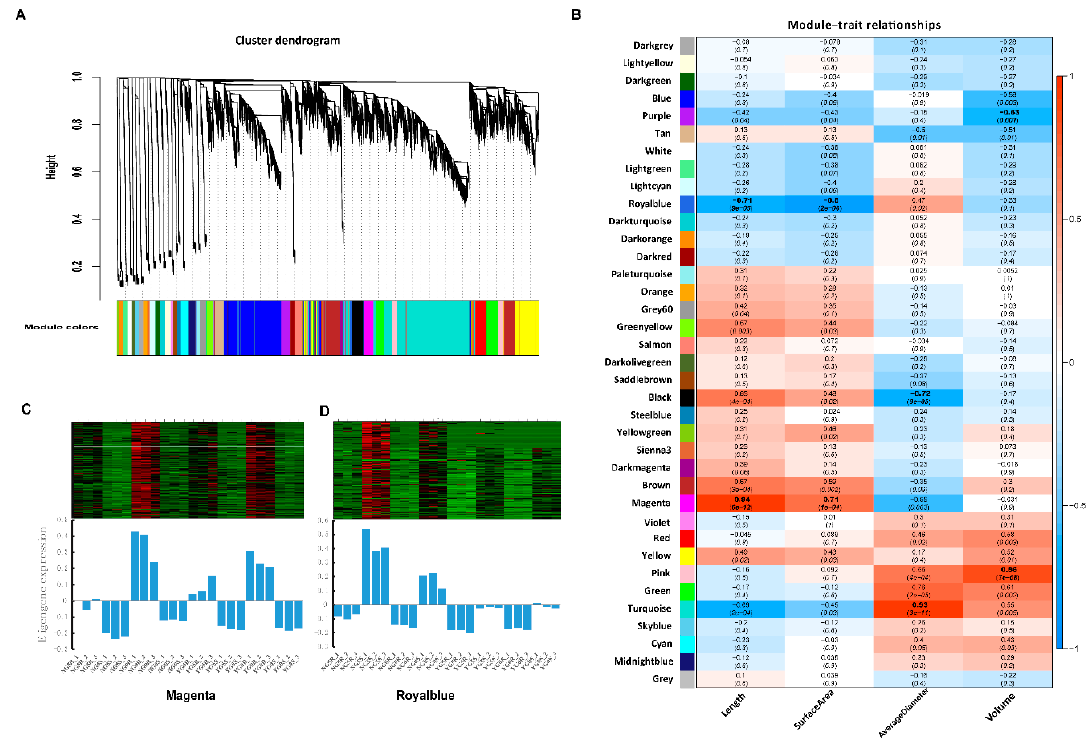
Figure 7. Weighted gene co-expression network analysis (WGCNA) of gene expressions and traits. ( A ) Hierarchical cluster tree showing 37 co-expression modules based on WGCNA. Each branch in the tree represents an individual gene; ( B ) Module—trait relationships and corresponding p -value. The panel on the left shows 37 modules and the panel on the right is the relevant color scale from − 1 to 1. The numbers above the parentheses represent the correlation coefficient ( r ), and the numbers in parentheses represent the significance ( p ). ( C ) Top half is heatmap showing the FPKM and lower part is the eigengene expression profile in magenta module; ( D ) Top half is heatmap showing the FPKM of each gene and lower part is the eigengene expression profile in royal blue module.